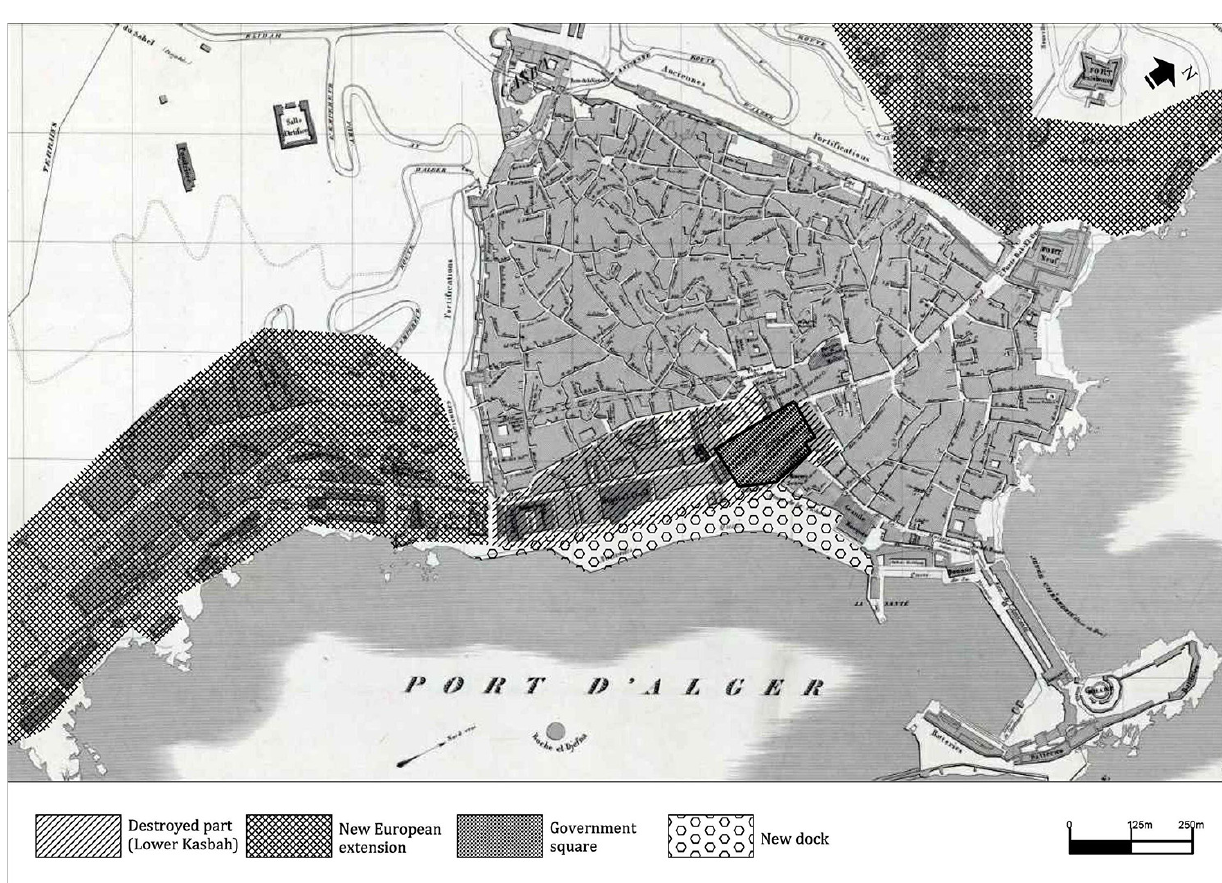
Figure 5. Map of Algiers in 1846. Source: Amended by the authors, based on Berbrugger